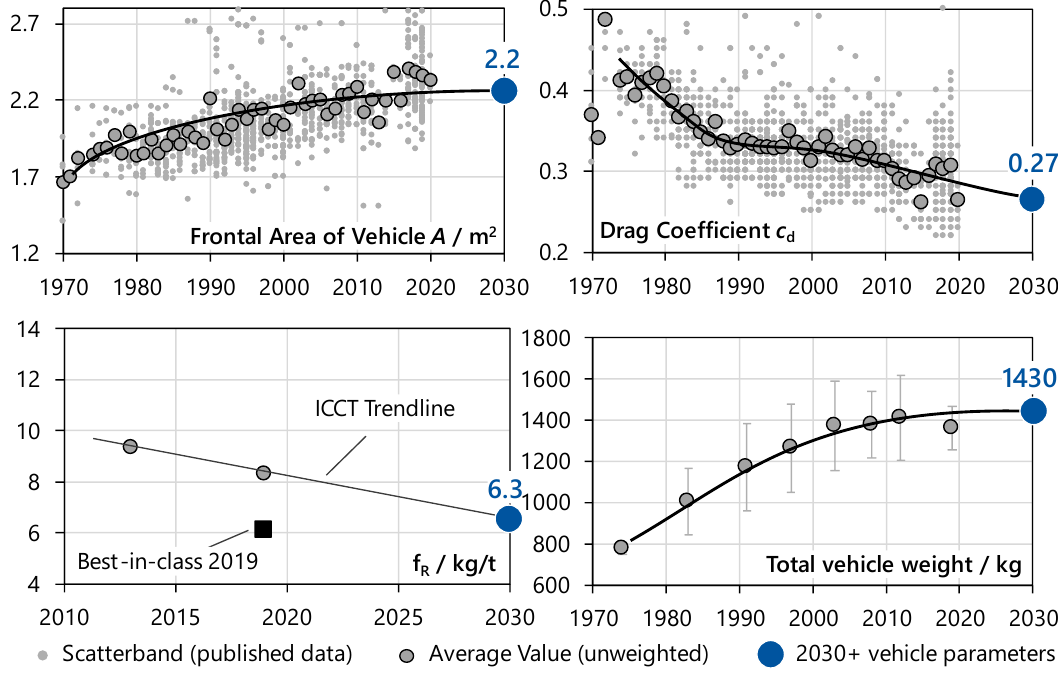
Figure 5. C-Segment scatter bands and average trends [37 – 39.]